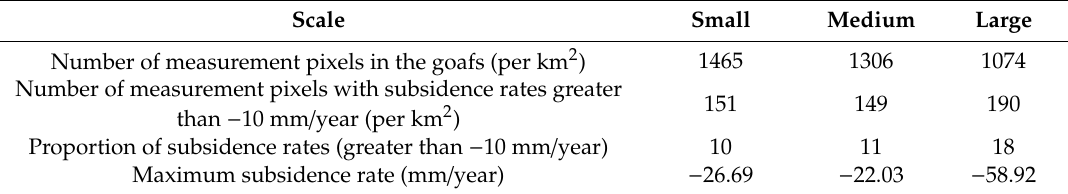
Table 4. Statistics of three scales of coal mining goafs from 2006 to 2011. Scale Small Medium Large Number of measurement pixels in the goafs (per km 2 ) 1465 1074